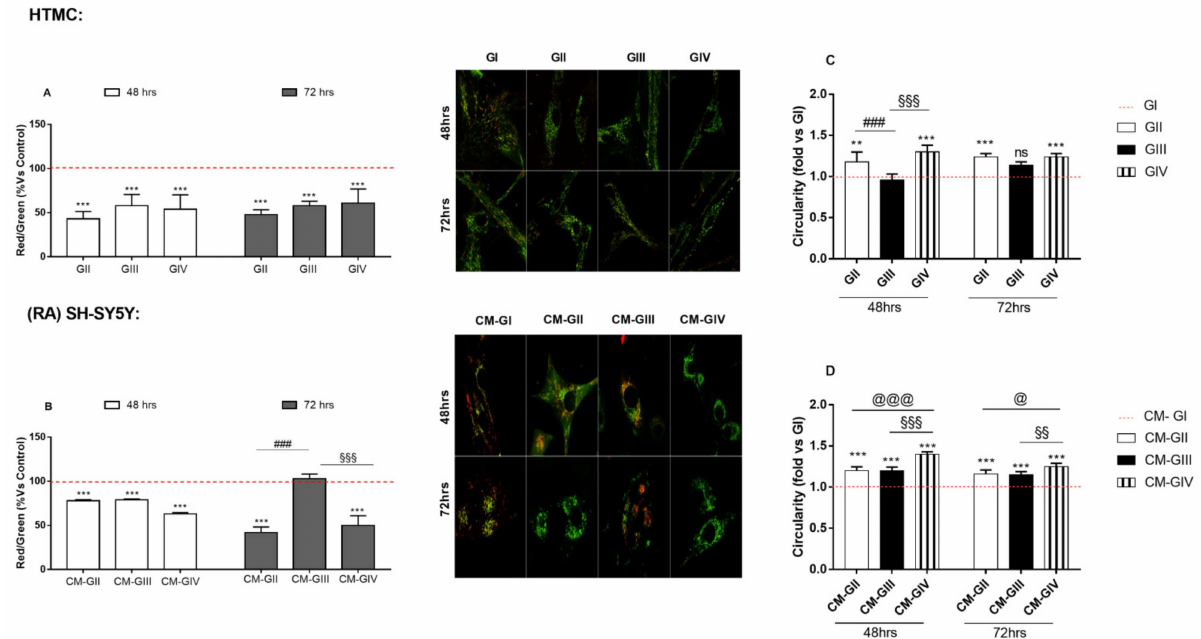
Figure 4. Mitochondrial membrane potential analysis. ( A , B ). The mitochondrial transmembrane potential was monitored in all experimental conditions by the JC-1 fluorochrome. On the left, quantitative analysis of ratio of red/green fluorescent intensity. Both red and green intensity were calculated for atleast 3 images of the same condition. Each measurement included ten areas of interest per image. On the right, confocal microscopy analyses of mitochondrial membrane potential were performed on 3D HTMC. Merged images show JC-1 dye both as monomer (green) and as J-aggregates (red). Mitochon- drial morphology ( C , D ). The mitochondrial morphology was evaluated by MitoTracker analysis. The bar diagram shows mitochondrial morphological changes both in HTMC and RA-SH-SY5Y analyzed by means of circularity. *** p < 0.001; ** p < 0.01 vs. control cell group; ###, §§§, @@@ p < 0.001; §§ p < 0.01; @ p < 0.05 vs. treated cell group (Two-way ANOVA followed by Bonferroni